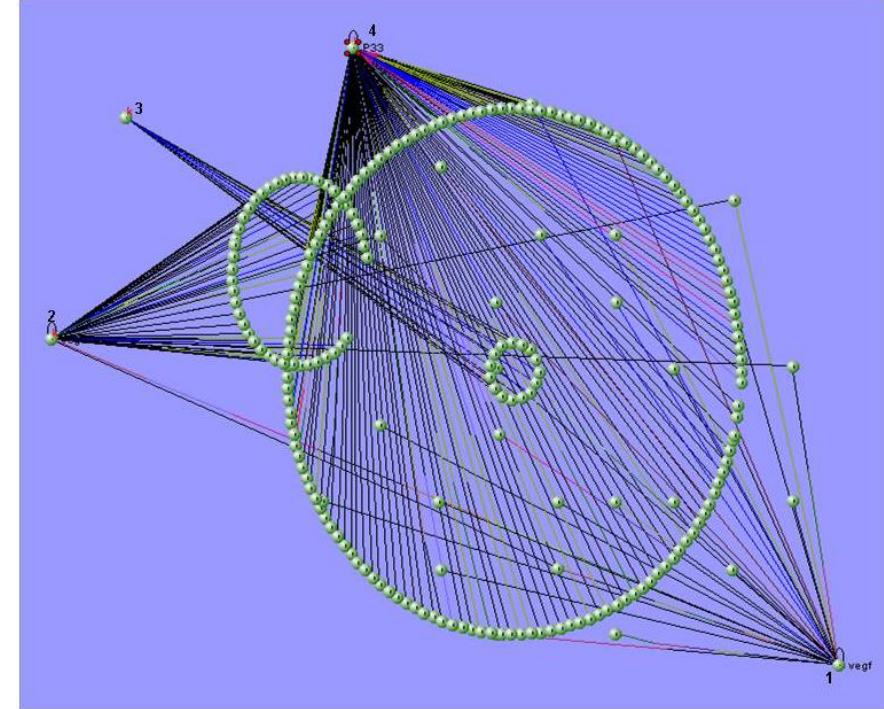
Figure 3. An illustration of the multi-scale visualization of biological interactions using VisANT’s metagraph capability. VisANT [54] is an integrative software platform for the visualization, mining, analysis and modeling of biological networks. This software extends the applications of GO for network visualization, analysis and inference. The image shows the biological networks between the molecules that belong to the VEGF signaling